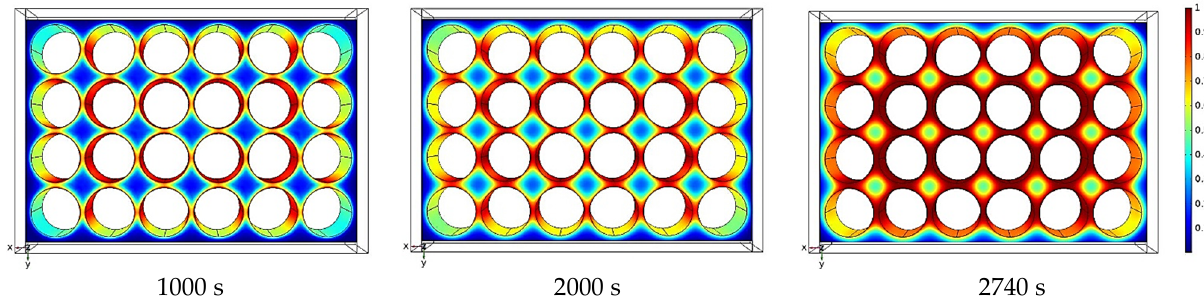
Figure 9. Liquid fraction contour of the PCM after 1000, 2000, and 2740 s under a 1.5C discharging rate.